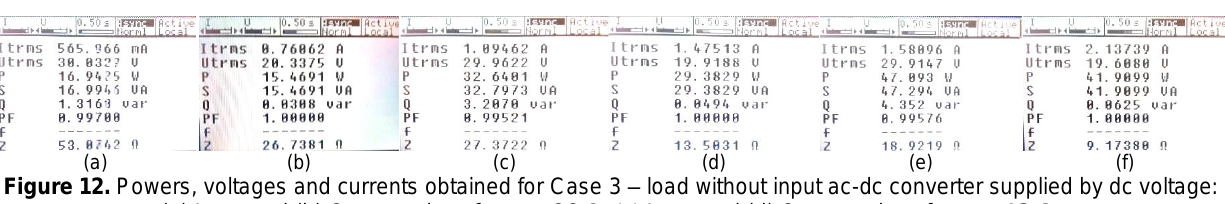
Figure 11. Powers, voltages and currents obtained for Case 2 – load supplied by dc voltage: (a) Input and (b) Output values for R o = 26 Ω; (c) Input and (d) Output values for R o = 13 Ω; (e) Input and (f) Output values for R o = 8.7 Ω.